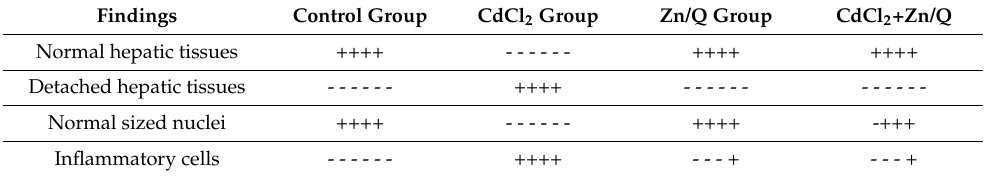
Table 4. Histopathological index in the hepatic tissues of rats treated with either CdCl 2 and/or